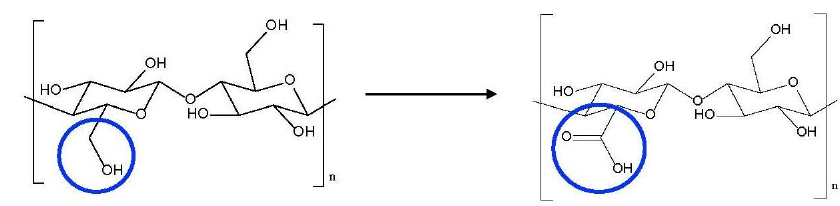
Figure 15. TEMPO mediated cellulose oxidation.